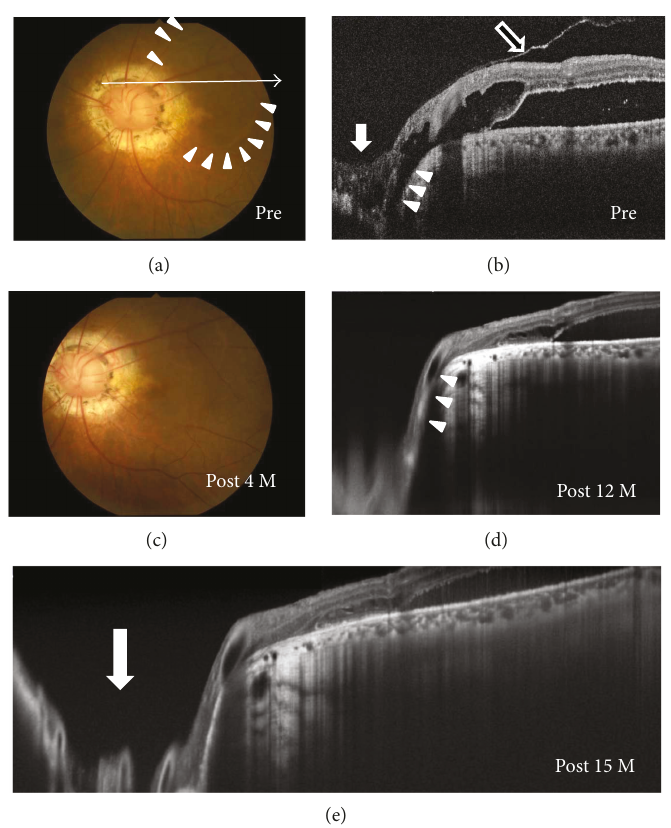
Figure 5: Photographs of the left eye in a 68-year-old patient with maculopathy associated with morning glory anomaly of the optic disc (case 5). (a, b) Preoperative images. Fundus photograph showed retinal detachment extending from the morning glory disc anomaly to the macula (a, arrowheads). Arrows indicate the optical coherence tomography (OCT) scan in Figure 5. A spectral domain OCT image showed retinal schisis with macular detachment and a tunnel-like hypore fl ectivity extending from the retinal schisis toward the disc (b, arrowheads), suggesting a communication between the disc and retinal schisis (b). The hyaloid membrane (b, black arrow) was attached around the disc and on the epipapillary glial tissue (b, white arrow). (c) Macular detachment was reduced at 4 months after